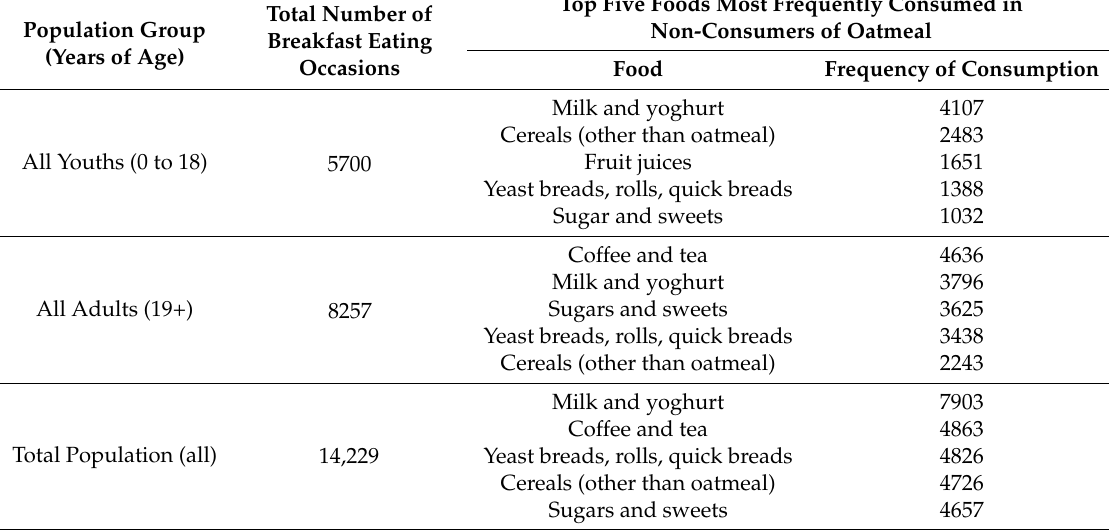
Table 6. Foods most commonly consumed at breakfast in non-consumers of oatmeal (data from Day 1 of the 2009–2012